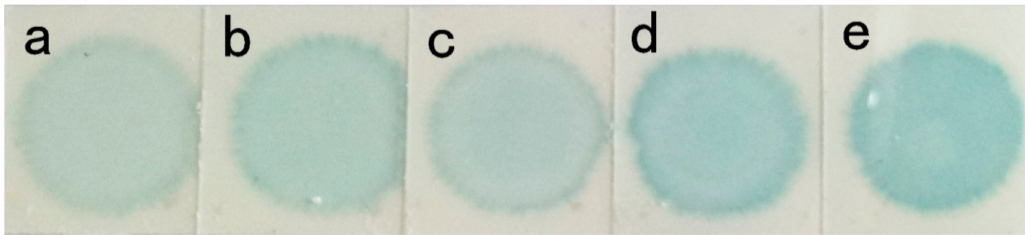
Figure 11. Image of different concentrations of HDL (( a ) 6.875 mg/dL, ( b ) 13.75 mg/dL, ( c ) 27.5 mg/dL, ( d ) 55 mg/dL, ( e ) 110